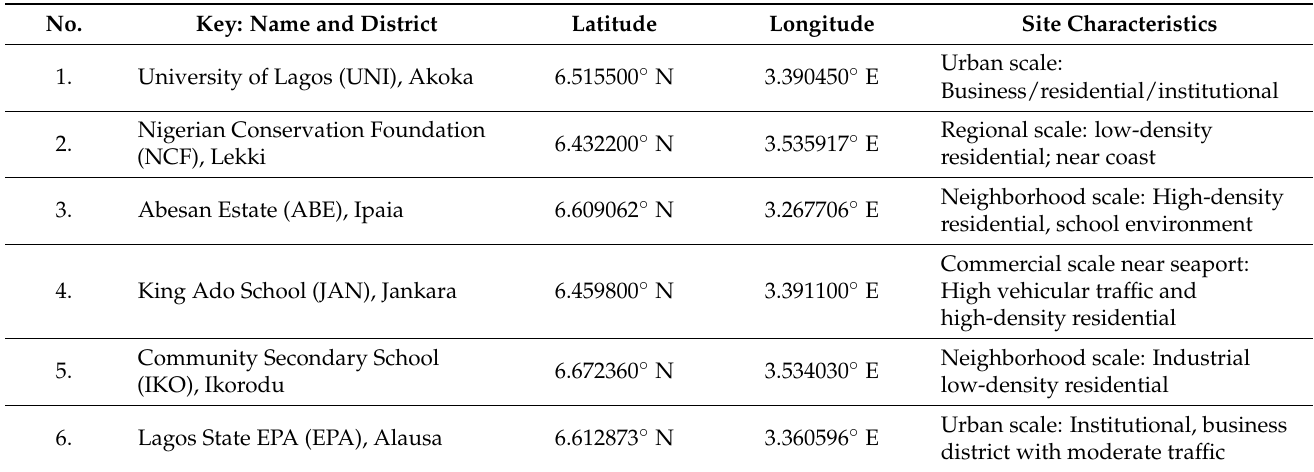
Table 1. Monitoring station locations and characteristics.